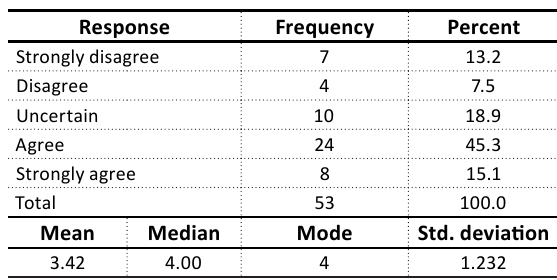
Table 1. Knowledge of green HRM practices